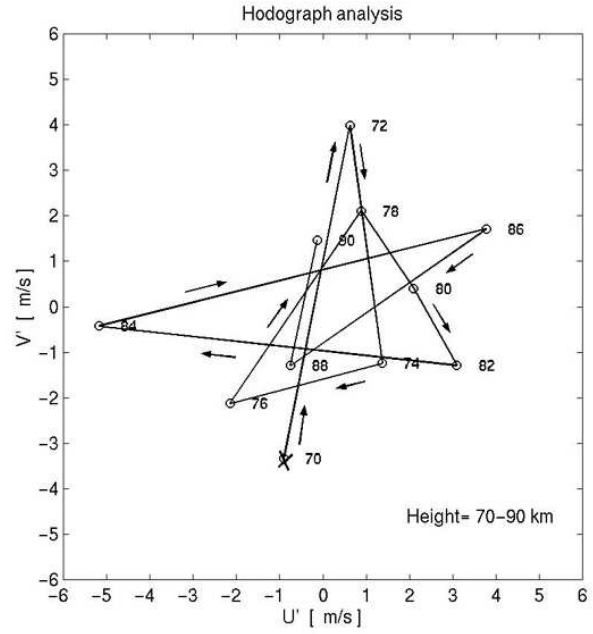
Fig. 10. Upper panel: The degree of wave polarization ˜ d(m) . Lower panel: ellipticity ( ˜ 8(m) thick line) and azimuth angle ( ˜ 2(m) thin line) of the gravity wave obtained by Stokes-parameter spectra tech- nique for wind disturbances (Andenes MF radar) between 21:30– 23:30 UT on 10 August 2000 and for the height range of 70–90km.